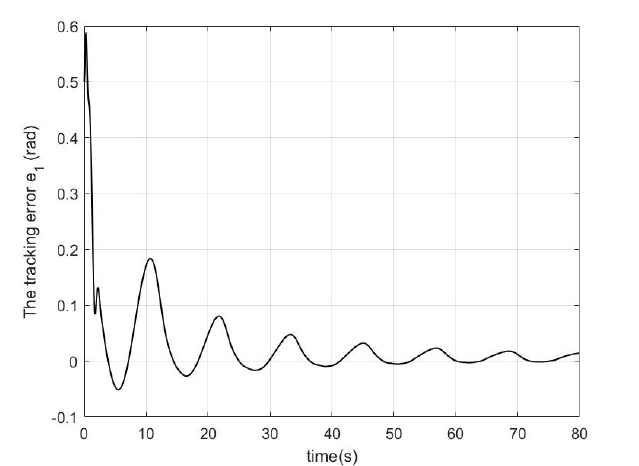
Figure 4. The performance of the tracking error e 1 in Case